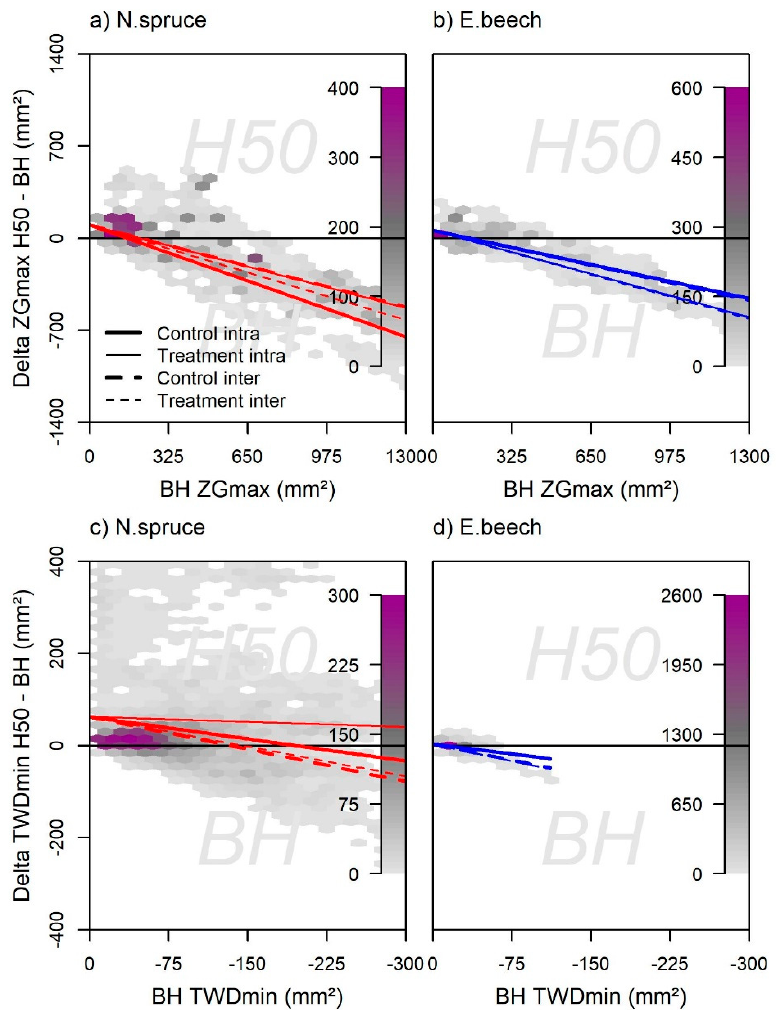
Figure 5. Relationship of growth (ZGmax) ( a , b ) and the tree water deficit (TWDmin) ( c , d ) represented by the difference of the measurements at 50% tree height (H50) and breast height (BH), dependent on the breast height measurement. Values below the zero line mean a growth allocation into the lower stem compartment at breast height. For the TWDmin, the negative values represent a lower tree water deficit at breast height. Linear mixed models depict how strongly the allocation was influenced by drought treatment (thick line—control, thin line—treatment) or mixture (intraspecific neighborhood—straight line, interspecific neighborhood—dashed line). The respective models are shown in Table 3.